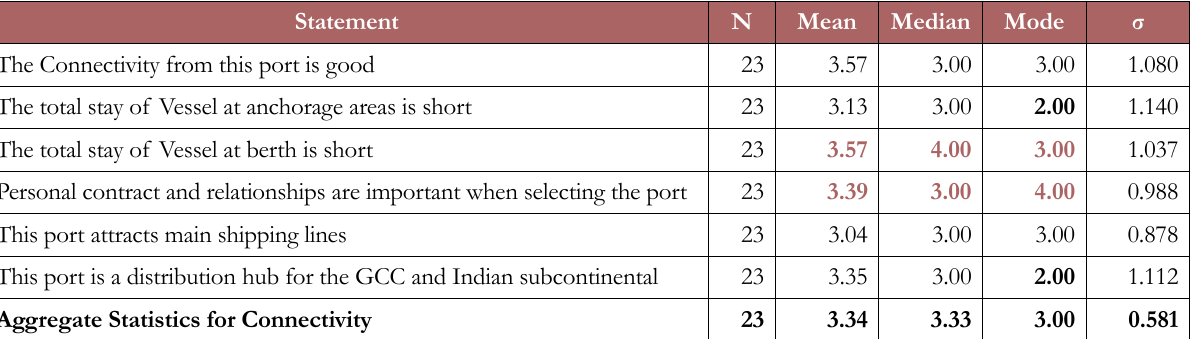
Table 6. Shipping Lines and Agents Perspectives on Sohar Port Connectivity